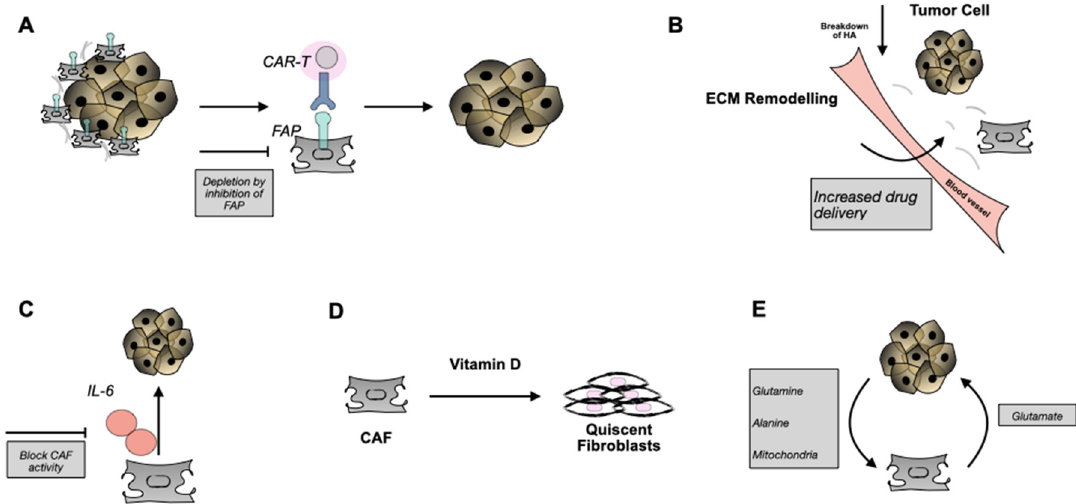
Figure 4. Overview of potential CAF interventions. ( A ) Use of anti-FAP mAbs or T-cells gene-engineered to express a FAP recognizing mAb (e.g., CAR-T cells) target FAP + CAFs and result in their immune cell-mediated destruction and removal. ( B ) Enzymatic breakdown of HA may lead to remodelling of ECM and better tumour accessibility for drugs and/or immune cells. ( C ) Block CAF activity through IL-6. ( D ) Transform CAFs into a more quiescent state via Vitamin D. ( E ) Tackle the metabolic need of tumour cells and their dependence on CAF metabolism. FAP: fibroblast activated protein, CAR: chimeric antigen receptor, HA: hyaluronic acid, IL-6 interleukin-6.